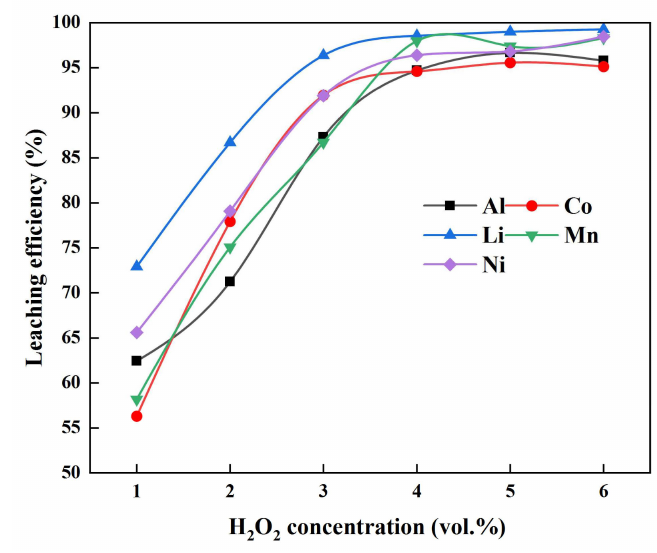
Figure 2. Effect of H 2 O 2 concentration on metal leaching